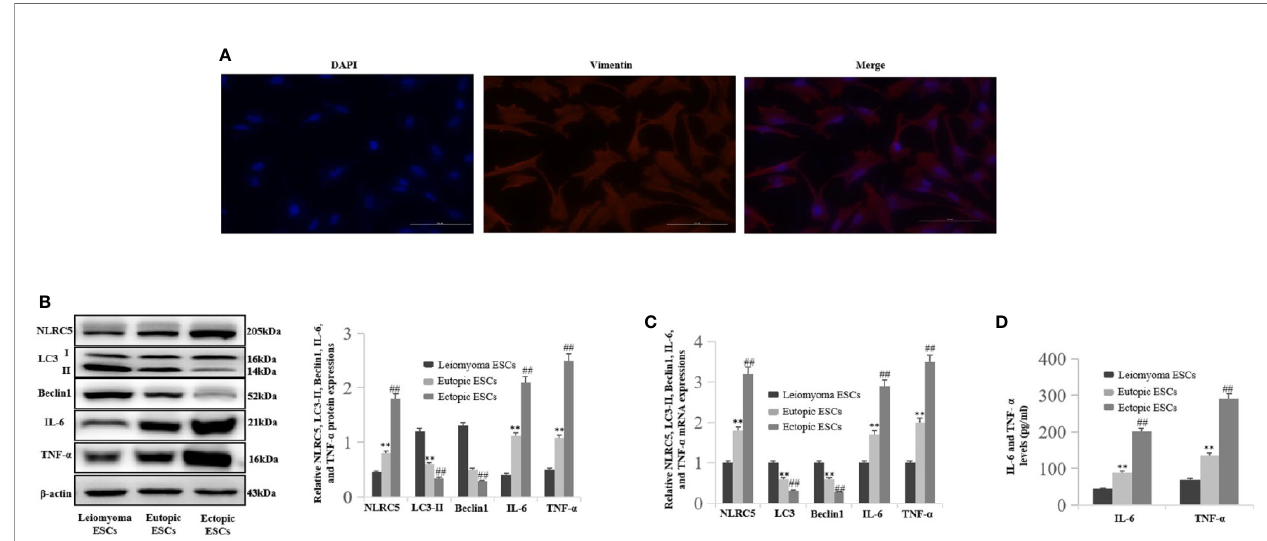
FIGURE 1 | The levels of NLRC5, in fl ammation, and autophagy in ESCs of patients with endometriosis (n = 5) and patients with leiomyoma (n = 5). (A) Representative image of immuno fl uorescence staining showing human ESCs displayed long-spindle with positively expressing vimentin and negatively expressing keratin. Photographs were taken at magni fi cations of 400×. (B , C) Representative western blotting and qRT-PCR showing NLRC5, IL-6, and TNF- a were up- regulated in endometriosis ectopic and eutopic ESCs of patients with endometriosis compared to the ESCs of patients with leiomyoma (**P < 0.01 vs. leiomyoma ESCs), and the levels of NLRC5, IL-6, and TNF- a in ectopic ESCs were also signi fi cantly higher than in the eutopic ESCs ( ## P < 0.01 vs. eutopic ESCs). Autophagy- related molecules LC3 and Beclin1 were down-regulated in ectopic and eutopic ESCs of patients with endometriosis compared to the ESCs of patients with leiomyoma (**P < 0.01 vs. leiomyoma ESCs), and the expression of LC3 and Beclin1 in ectopic ESCs was also signi fi cantly lower than in the eutopic ESCs ( ## P < 0.01 vs. eutopic ESCs). (D) Representative ELISA showing IL-6 and TNF- a were up-regulated in endometriosis ectopic and eutopic ESCs of patients with endometriosis compared to the ESCs of patients with leiomyoma (**P < 0.01 vs. leiomyoma ESCs), and the levels of IL-6 and TNF- a in ectopic ESCs were also signi fi cantly higher than in the eutopic ESCs ( ## P < 0.01 vs. eutopic ESCs). The expression levels of mRNA were normalized with respect to b -actin and were calculated using the 2 - DD Ct method. The protein expression levels were quanti fi ed by Image J software and normalized to b -actin protein levels. The results are represented as the mean ± SEM from at least three independent